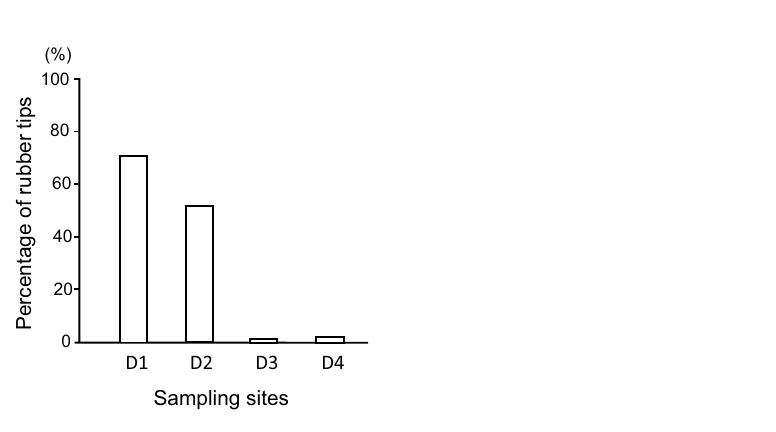
Figure 2. Fraction (%) of rubber tips in the sediment. D1–D4 indicate the four sites in the ditch where sediments were